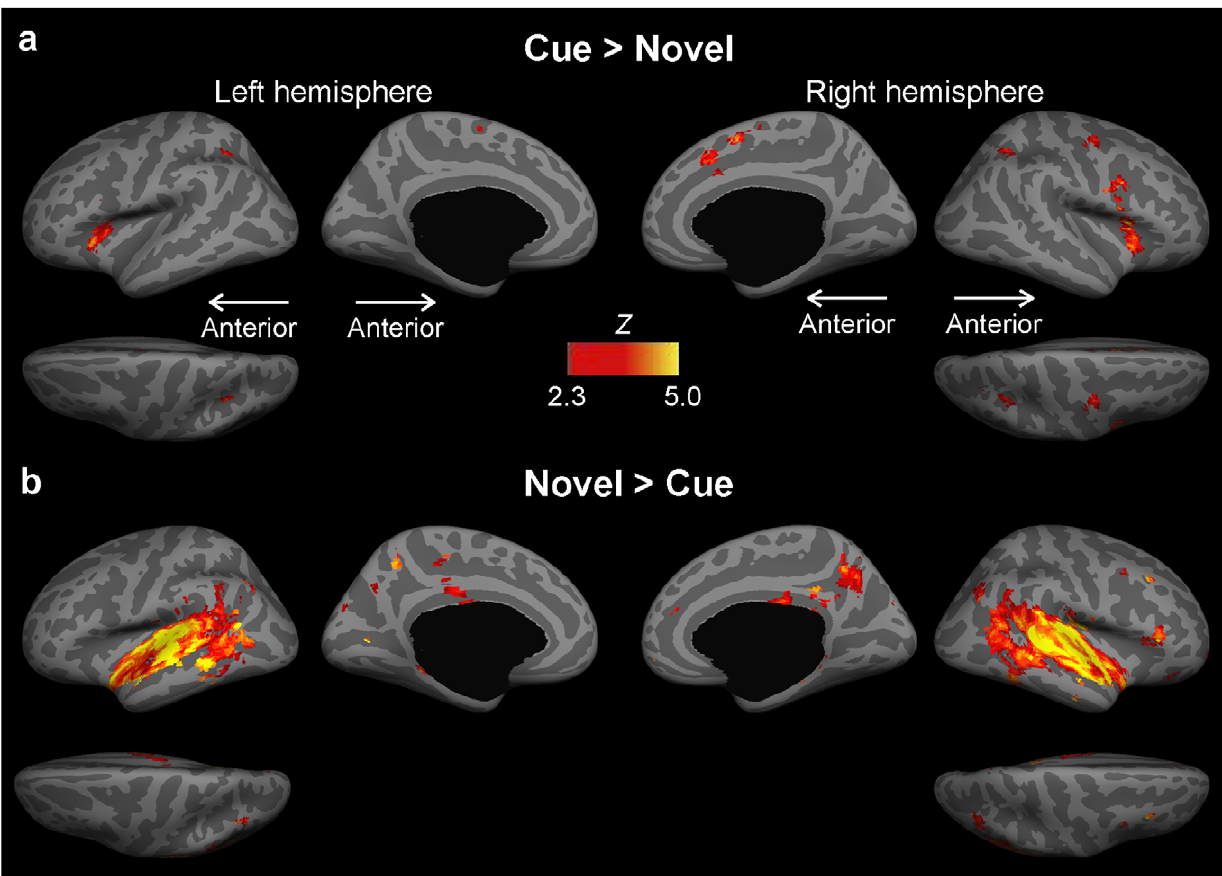
Figure 4. Areas Activated by the Cue vs. Novel and Novel vs. Cue Contrasts. Increased activations associated with Cue vs. Novel contrast were observed in bilateral FEF, mSFC/aMCC, anterior insula, and the anterior/superior aspect of IPS, as well as right PMC and IFC. Increased activations associated with Novel vs. Cue contrast were most prominently in the bilateral primary and non-primary auditory cortex, TPJ, and the inferior aspect of IPS. The contrasts were calculated at the second-level using a random-effects group analysis thresholded at P , 0.01.